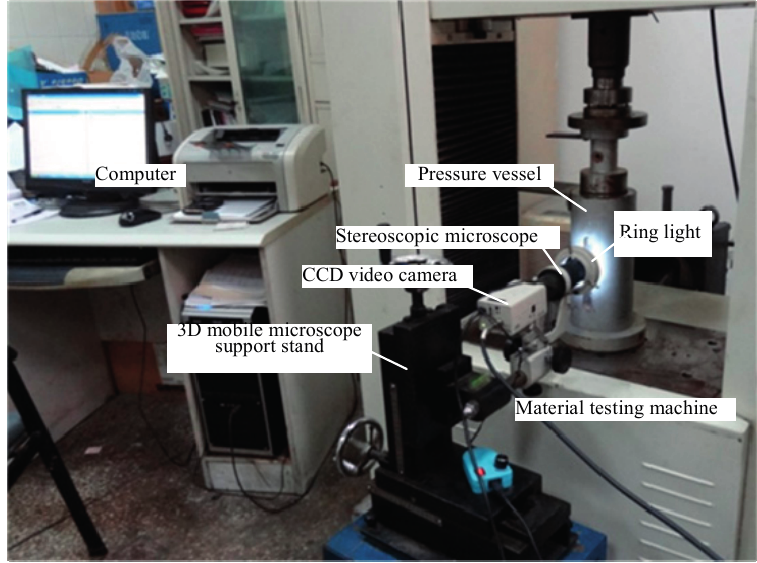
Figure 1. The testing apparatus.